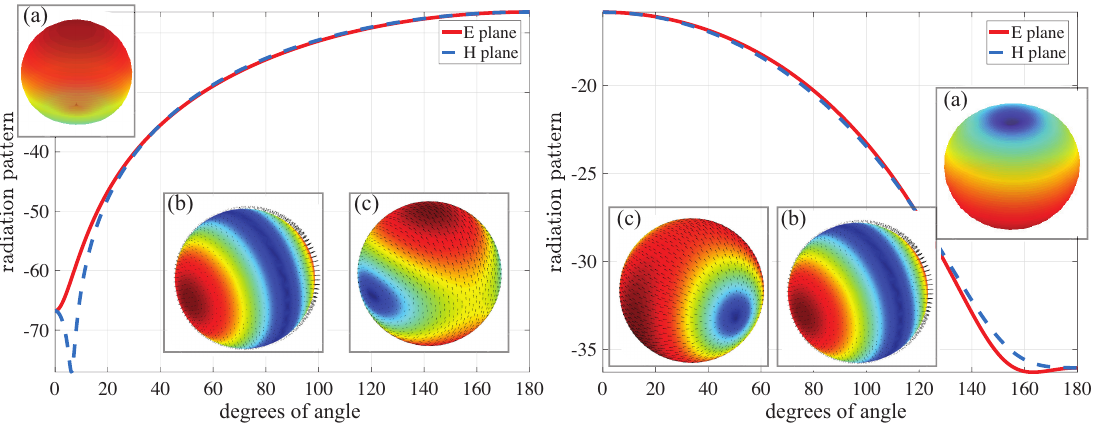
Figure 10. The radiation and surface field patterns of maximum forward scattering (left set of images) and maximum backscattering (right set of images). Left : The central subfigure illustrates the far field radiation pattern (in dB) of the maximum forward scattering for both perpendicular planes, E and H , spanning between 0 degrees (backward scattering direction) to 180 degrees of angle (forward scattering direction). The inset subfigures depict: ( a ) 3D far-field pattern; ( b ) the surface electric field; and ( c ) the tangential magnetic field. Right : Similarly, the backscattering radiation pattern, i.e.,: ( a ) 3D far-field pattern; ( b ) the surface electric field; and ( c ) the tangential magnetic field. Note the differences in direction of the radiation patterns and the differences in the orientation of the magnetic